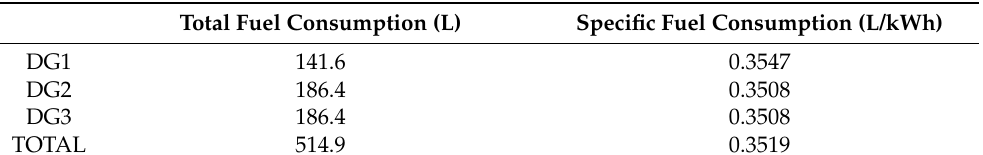
Table 5. DG units total and specific fuel consumption for off-grid operation (case with BESS outage and PV plant limited to 50% of ASC demand).